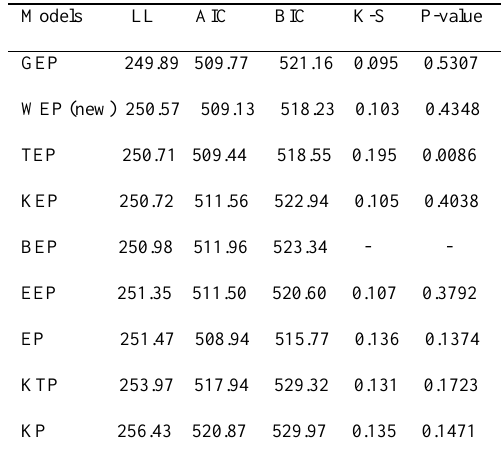
Table 4. Goodness-of-fits estimates for Wheaton river data